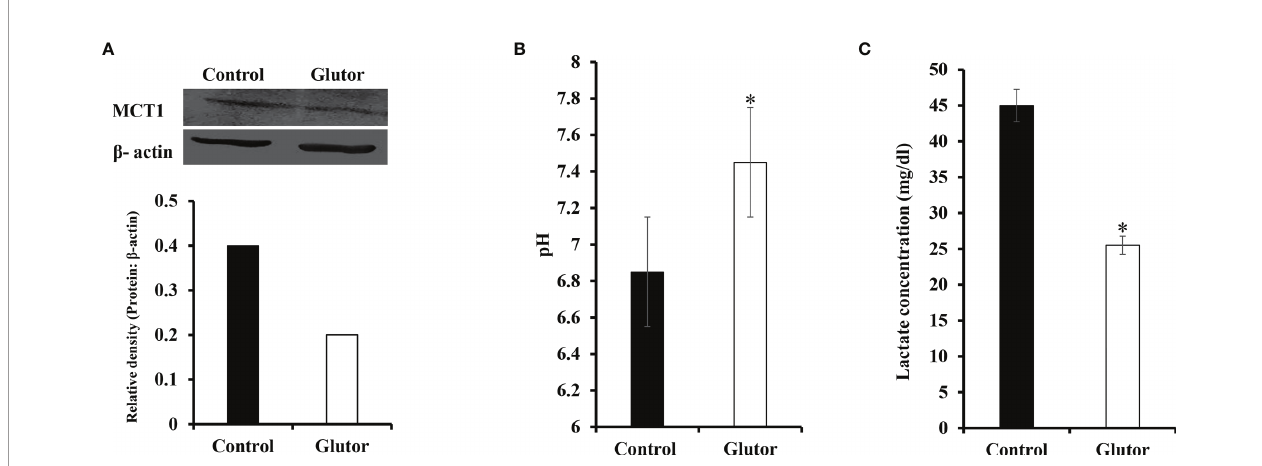
FIGURE 7 | Glutor interferes with pH homeostasis of DL cells. DL cells (1 × 10 5 ) were incubated for 24 h in a medium alone or containing glutor (0.01 µM), followed by an examination of MCT1 expression by Western blotting as described in the Materials and Methods section. The culture media of control and glutor-treated DL cells were also examined for pH and lactate levels. The plates shown in (A) are from a representative experiment out of at least two experiments with similar results. The accompanying bar diagram depicts the densitometry of the bands. Values in (B) and (C) are mean ± SD. * p < 0.05 vs. respective